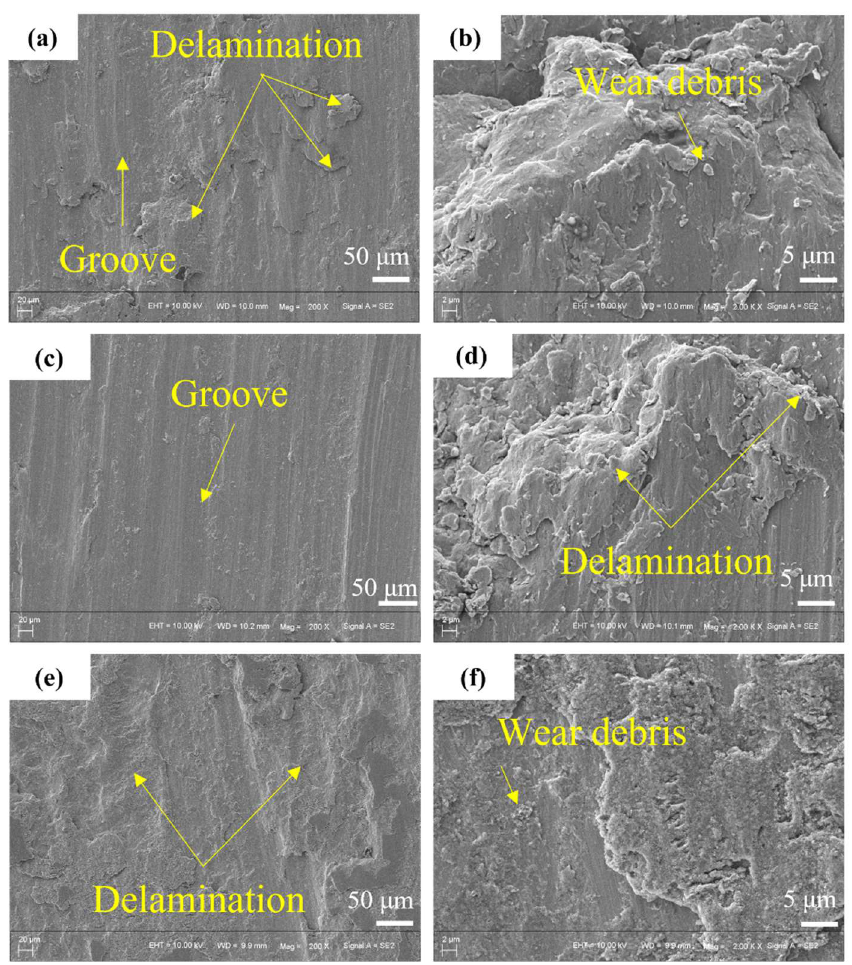
Figure 8. Wear morphologies of Al x Ti 1− x coatings: ( a , b ) Al 0 Ti 1 , ( c , d ) Al 0.5 Ti 0.5 , ( e , f ) Al 1 Ti 0.